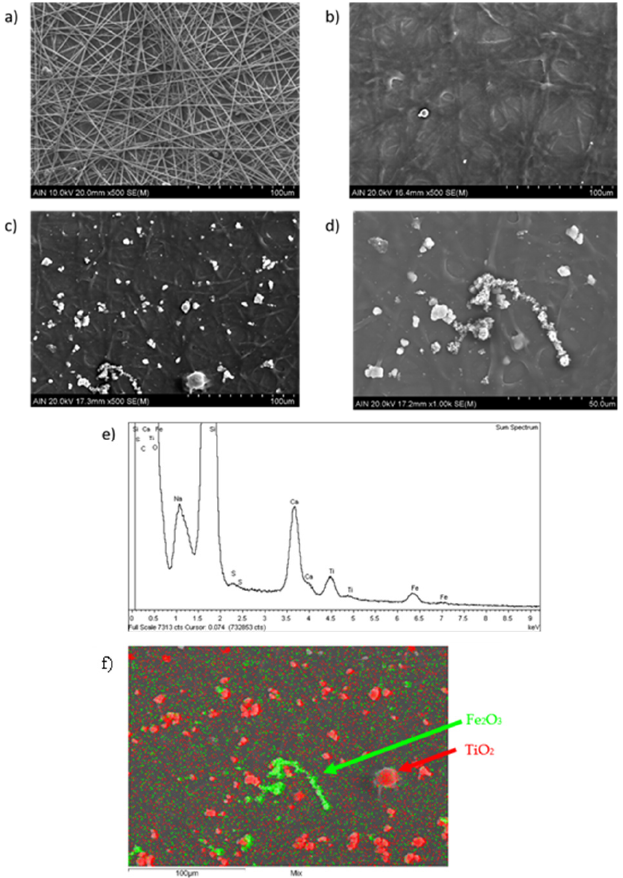
Figure 4. SEM images of the functional coatings composed of ( a ) only electrospun PAA + β -CD fibres (REF) ( b ) combination of PAA + β -CD//PDDA/PSS (S0) and ( c , d ) combination of PAA + β -CD//PDDA + TiO 2 /PSS + Fe 2 O 3 (S01); ( e ) EDX analysis of the sample S01 with the presence of Ti and Fe peaks, respectively; ( f ) EDX 2D mapping of the sample S01 with the presence of Fe 2 O 3 and TiO 2 particles.